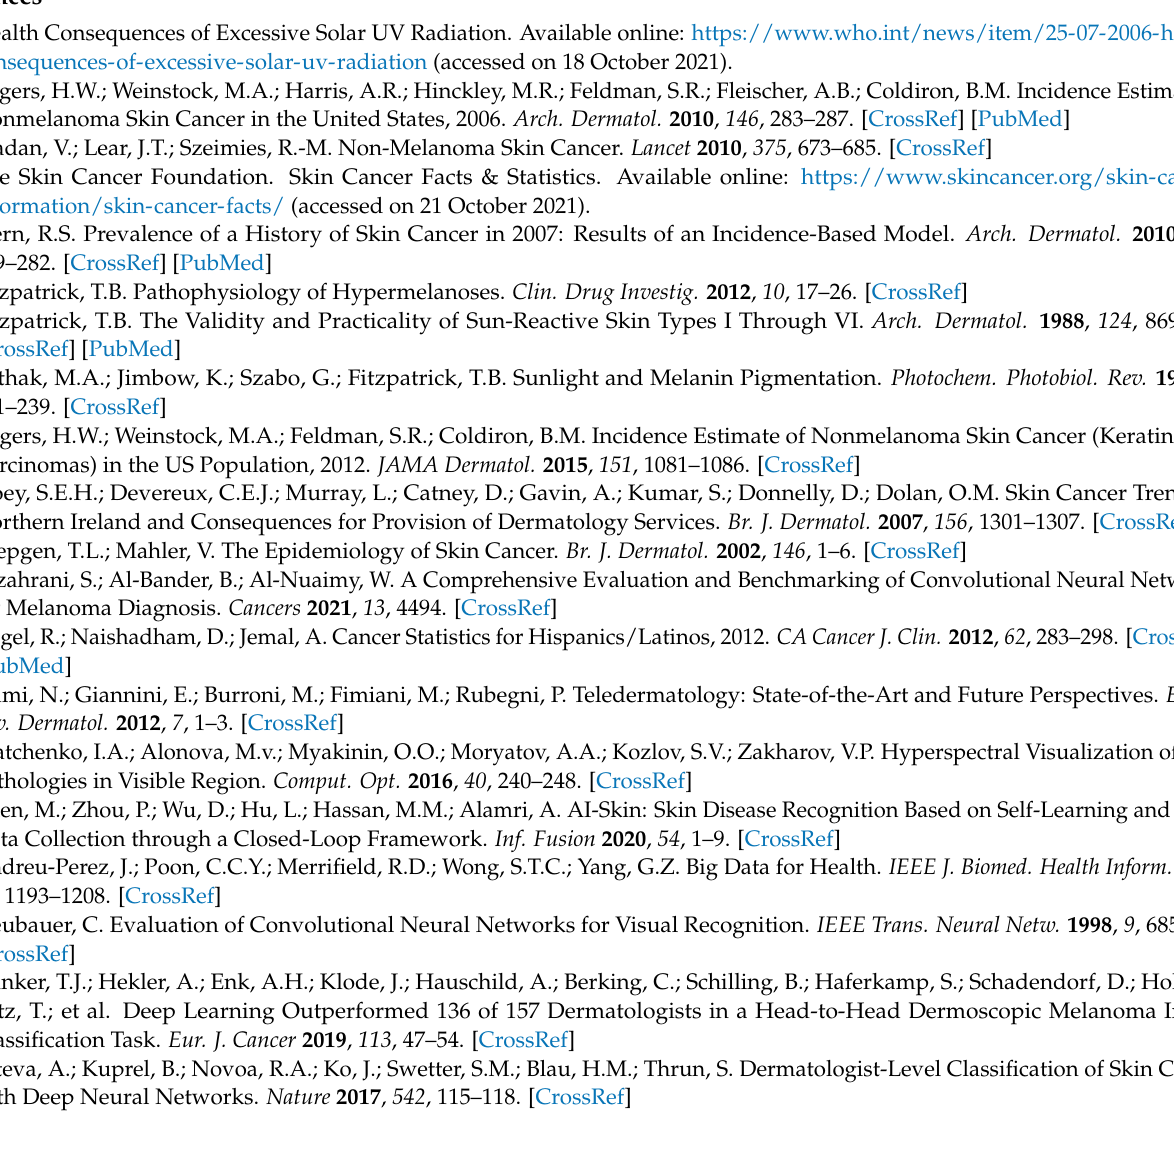
Figure A3. Graph of learning outcomes of a multimodal neural network system for classifying dermatoscopic images of pigmented skin lesions based on CNN ResNet ‐ 101: ( a ) loss function; ( b ) recognition accuracy.